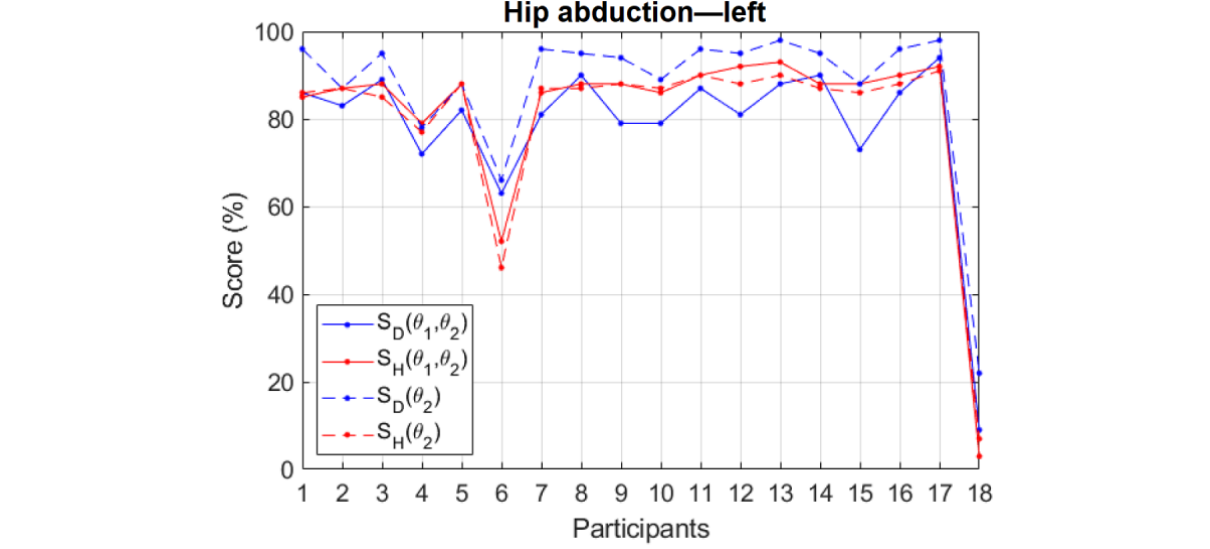
Figure 8. The effect on the scores of removing minor